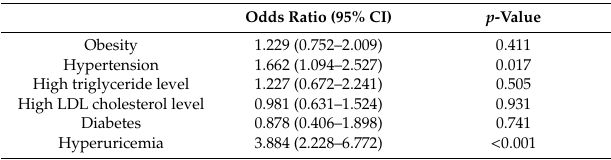
Table 6. Risk factors of chronic kidney disease in non-NAFLD.